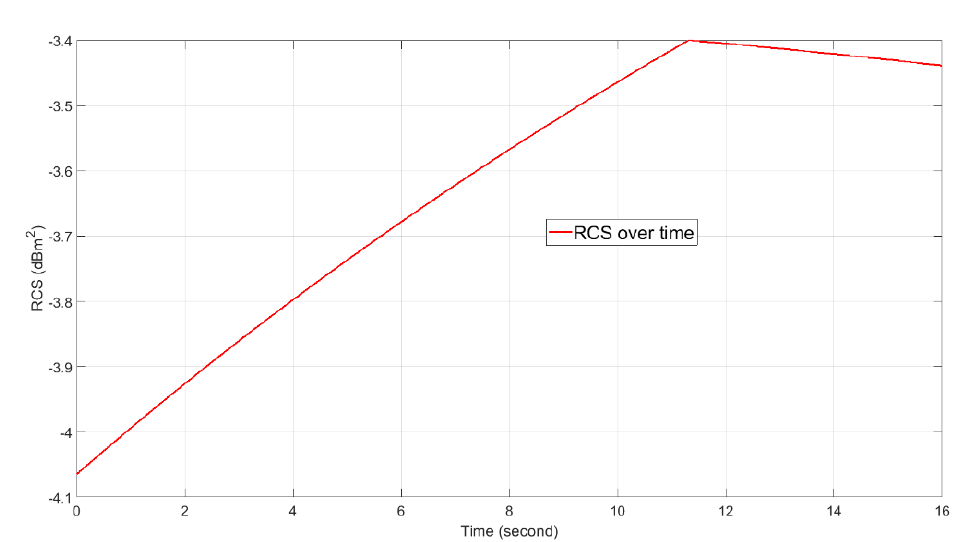
Figure 9. The target RCS vs. time.